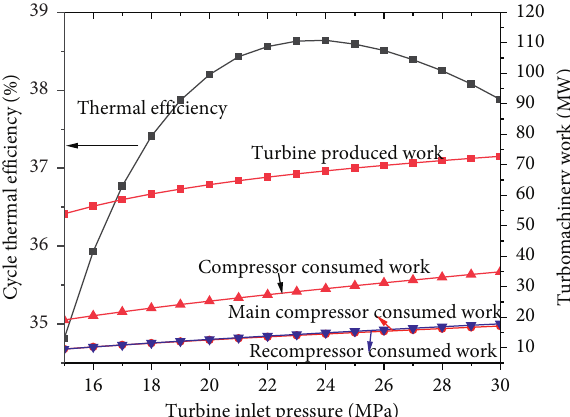
Figure 13: Effects of TIP on the cycle thermal efficiency for RBC.